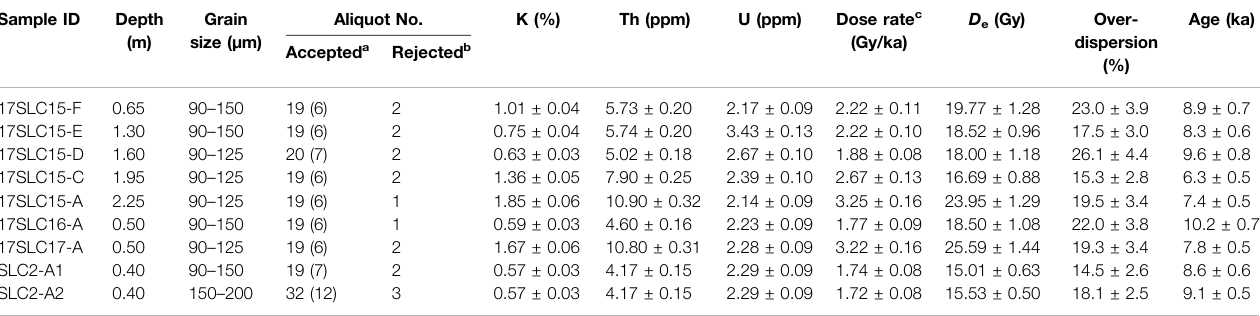
TABLE 2 | OSL dating